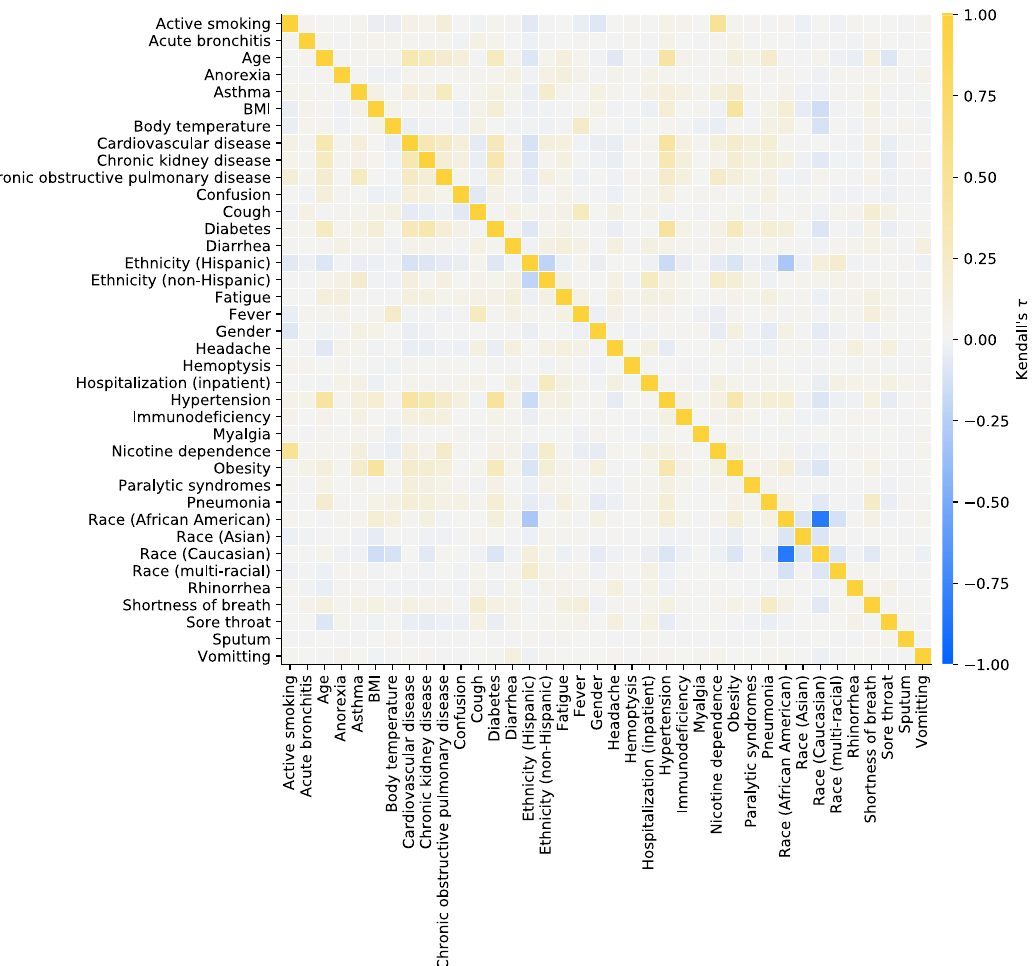
Fig. 3 Feature concurvity. Kendall ’ s τ was used to evaluate correlation between each feature combination (prior to feature exclusion in feature set pre-processing). Table 3. Performance comparison.